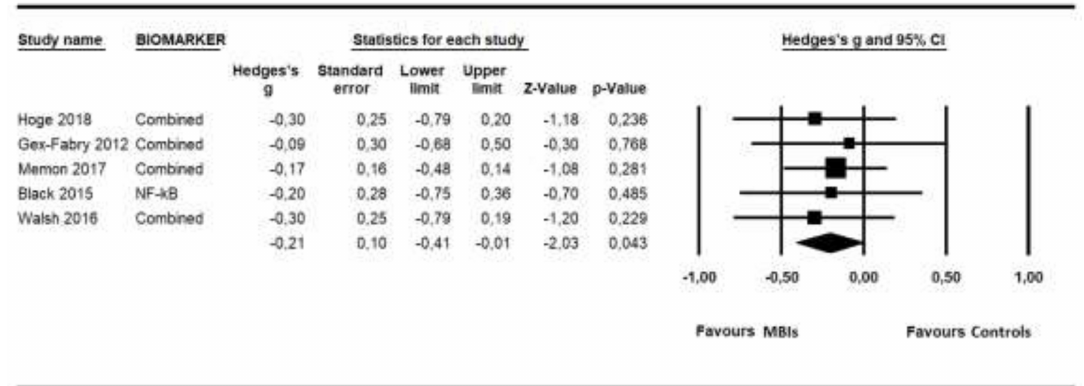
Figure 4. Forest Plot for the overall e ff ect size of low-grade inflammatory